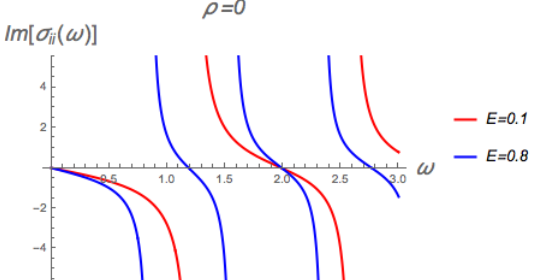
Figure 9 . Imaginary part of the longitudinal (cid:27) xx = (cid:27) yy conductivities in the case (cid:26) = 0 (Minkowski embedding), E < B